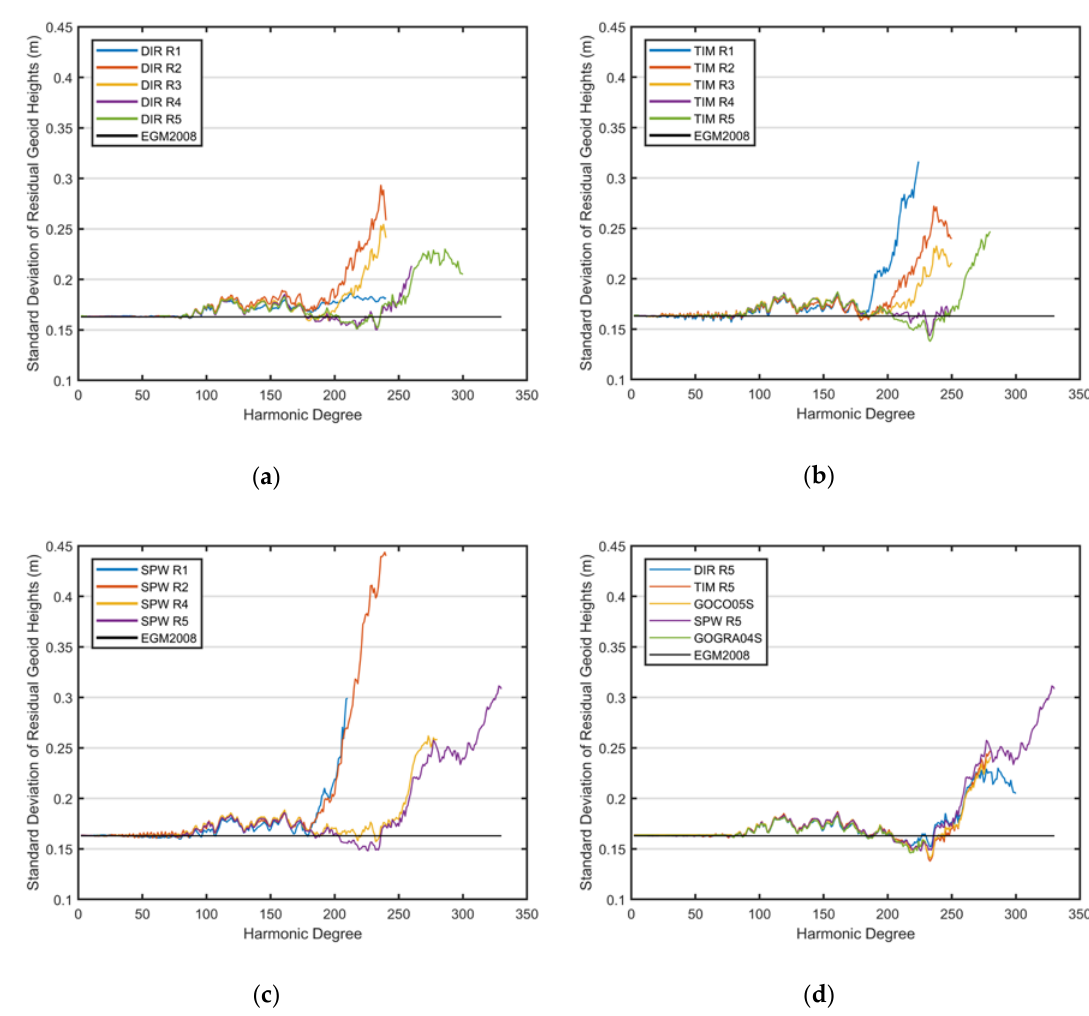
Figure 4. Validation of global geopotential models (GGMs) regarding the standard deviations of the geoid undulation residuals ( N GPS / lev . − N enh . ) in meters (for Dataset I): ( a ) DIR RLx models; ( b ) TIM RLx models; ( c ) SPW RLx models; ( d ) comparison among the last versions of the satellite-based and combined models.